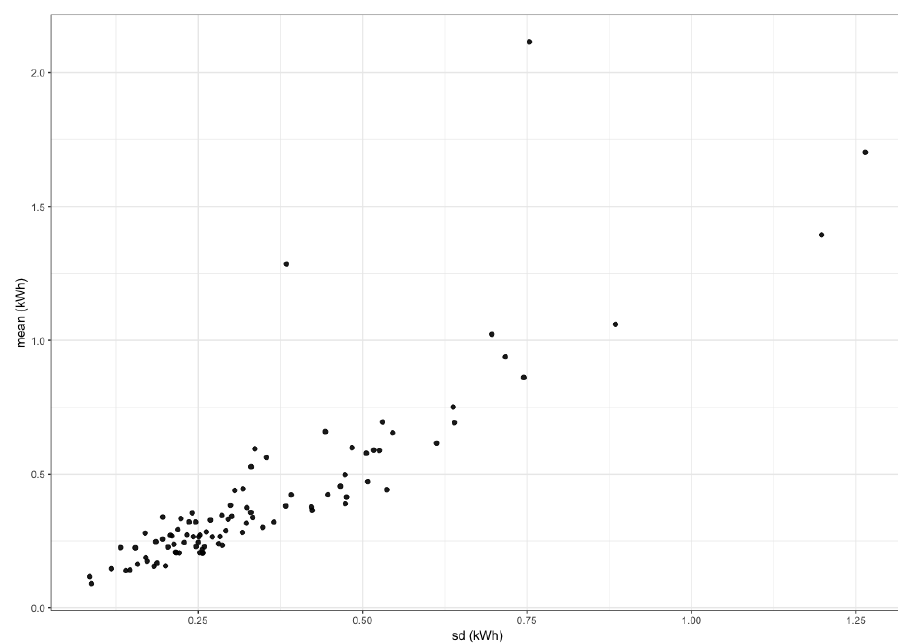
Figure 3. Average consumption vs standard deviation for each smart meter.